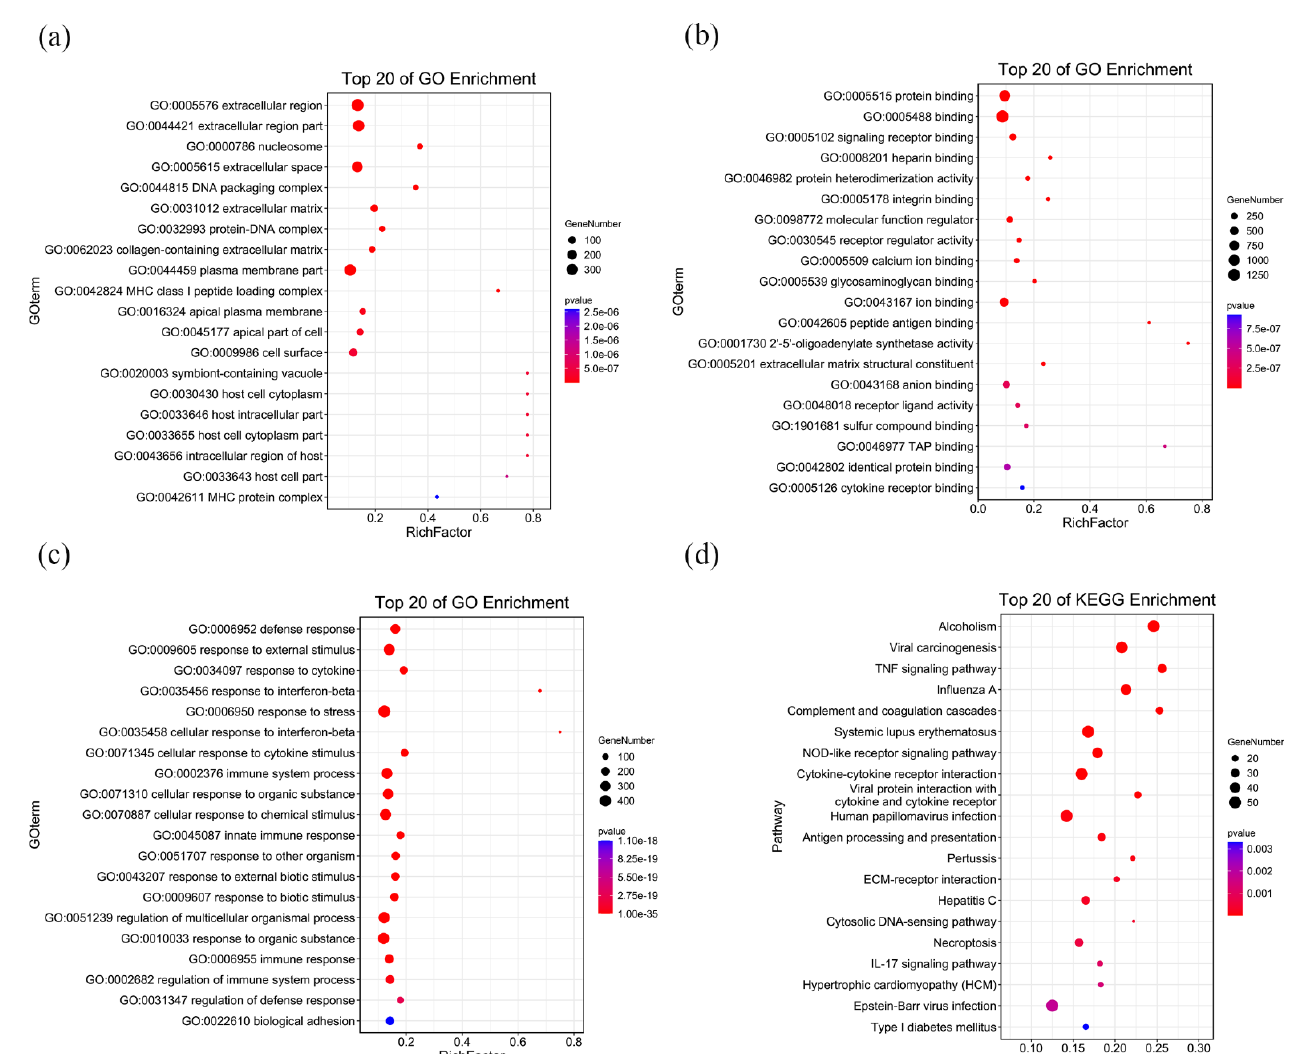
Figure 3. DEGs profiling by RNA-seq. ( a ) Heatmap of RNA-seq. ( b ) Volcano plots of RNA-seq. ( c ) Reliability verification of RNA-seq data. ( d ) Up-top 10 in network string – string interactions ranked by Degree method. ( e ) Down-top 10 in network string – string interactions ranked by Degree method.